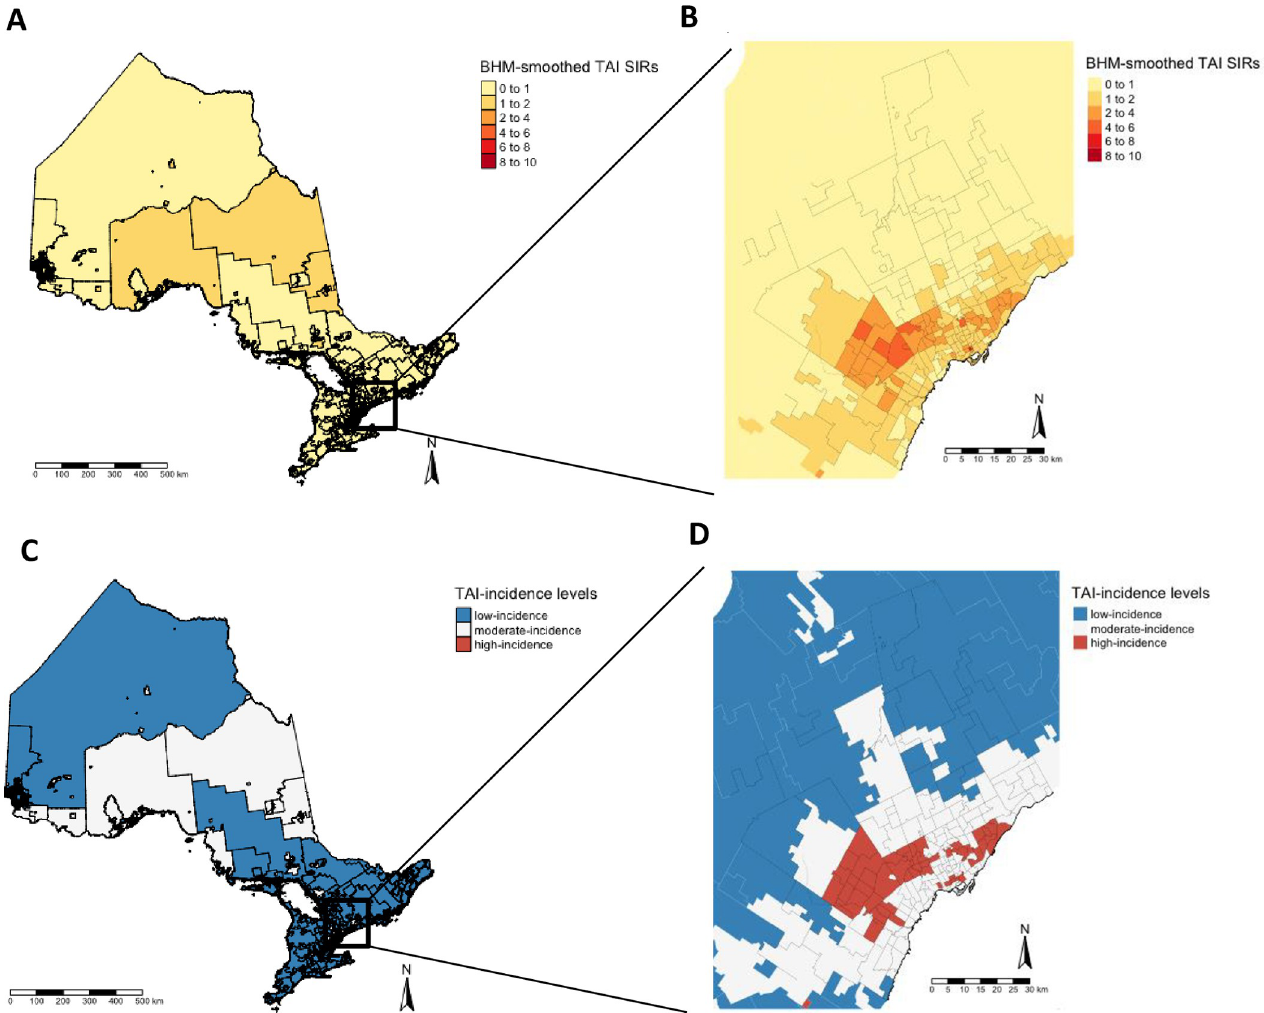
Fig 2. Standardized travel-acquired infection incidence across Ontario, Canada. Bayesian hierarchical model (BHM) smoothed standardized incidence ratios (SIRs) for travel-acquired infections (TAIs) and estimated incidence levels (panels A and C) with insets for the Greater Toronto Area (B and D). High- incidence areas are defined as those with smoothed SIR 95% credible intervals (Cis) greater than 1 and low-incidence areas with smoothed SIR 95% CIs less than 1. Adapted from Statistics Canada, 2016 Census–Boundary Files, 2019-11-13. This does not constitute an endorsement by Statistics Canada of this